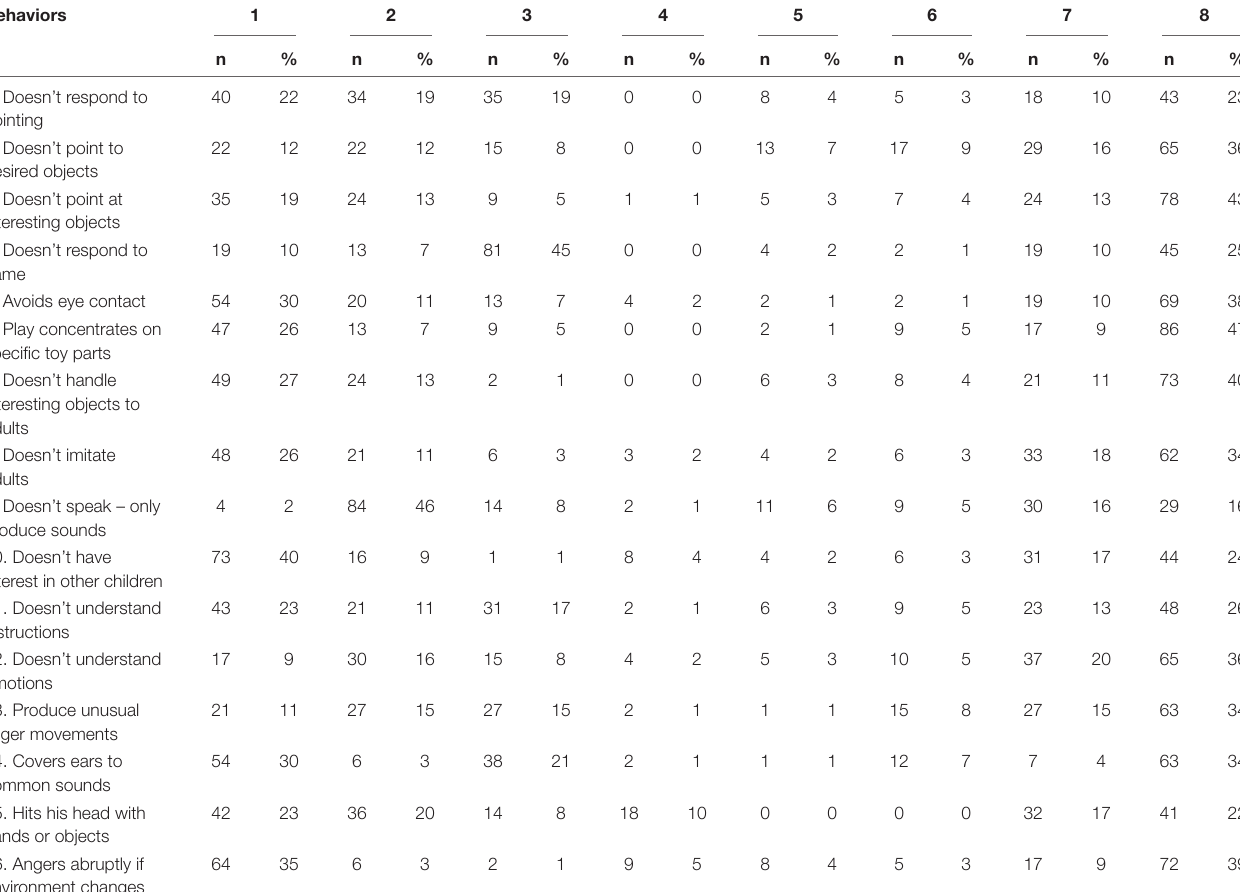
TABLE 3 | Causal attributions repartition in eight categories by 183 adults in % in function of 16 behaviors.